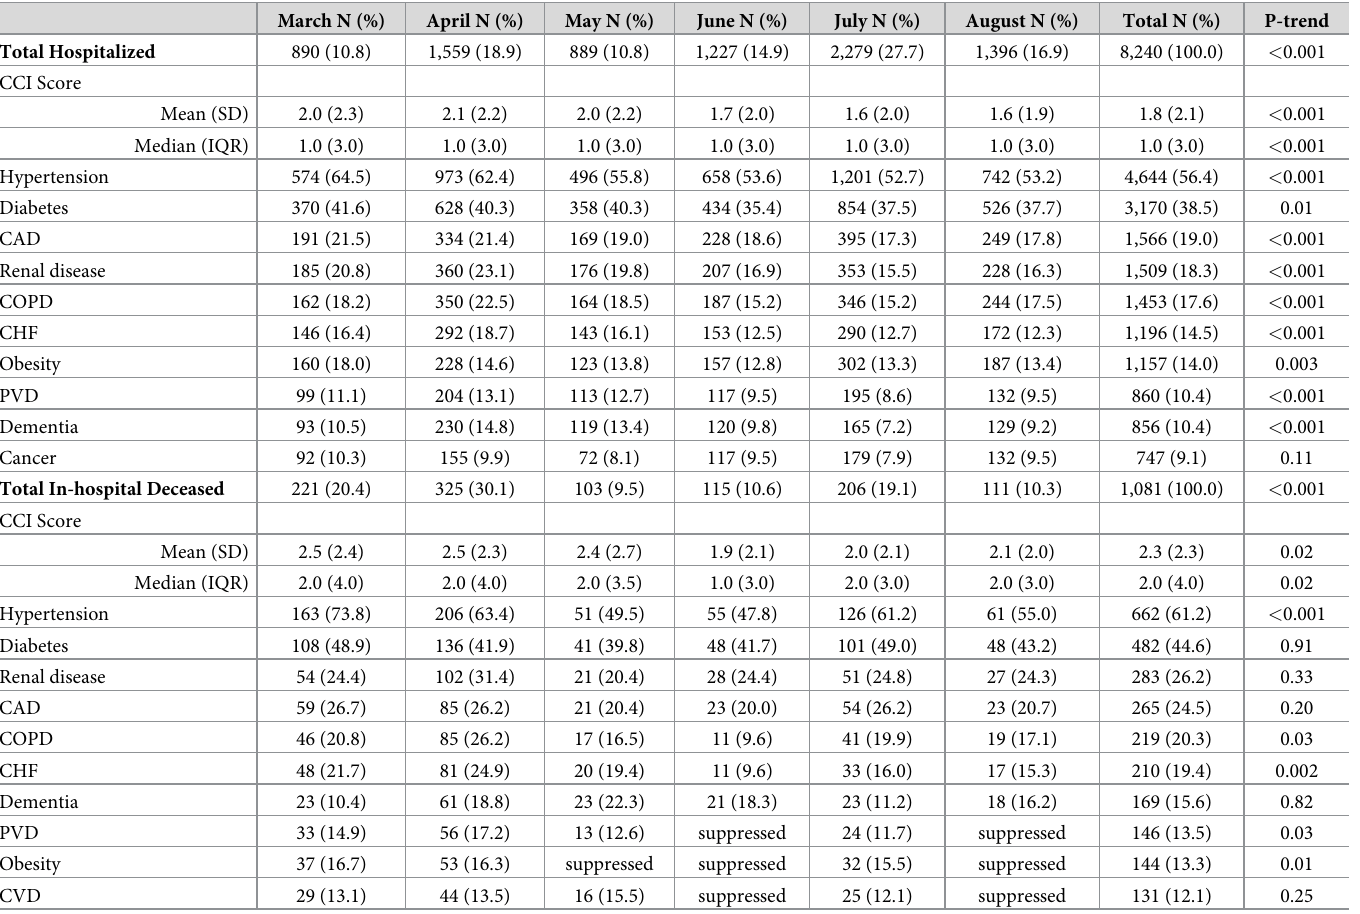
Table 3. Top 10 clinical comorbidities � among hospitalized and in-hospital deceased Veterans Health Administration users with coronavirus disease 2019 (COVID-19), March 1, 2020 –August 31,